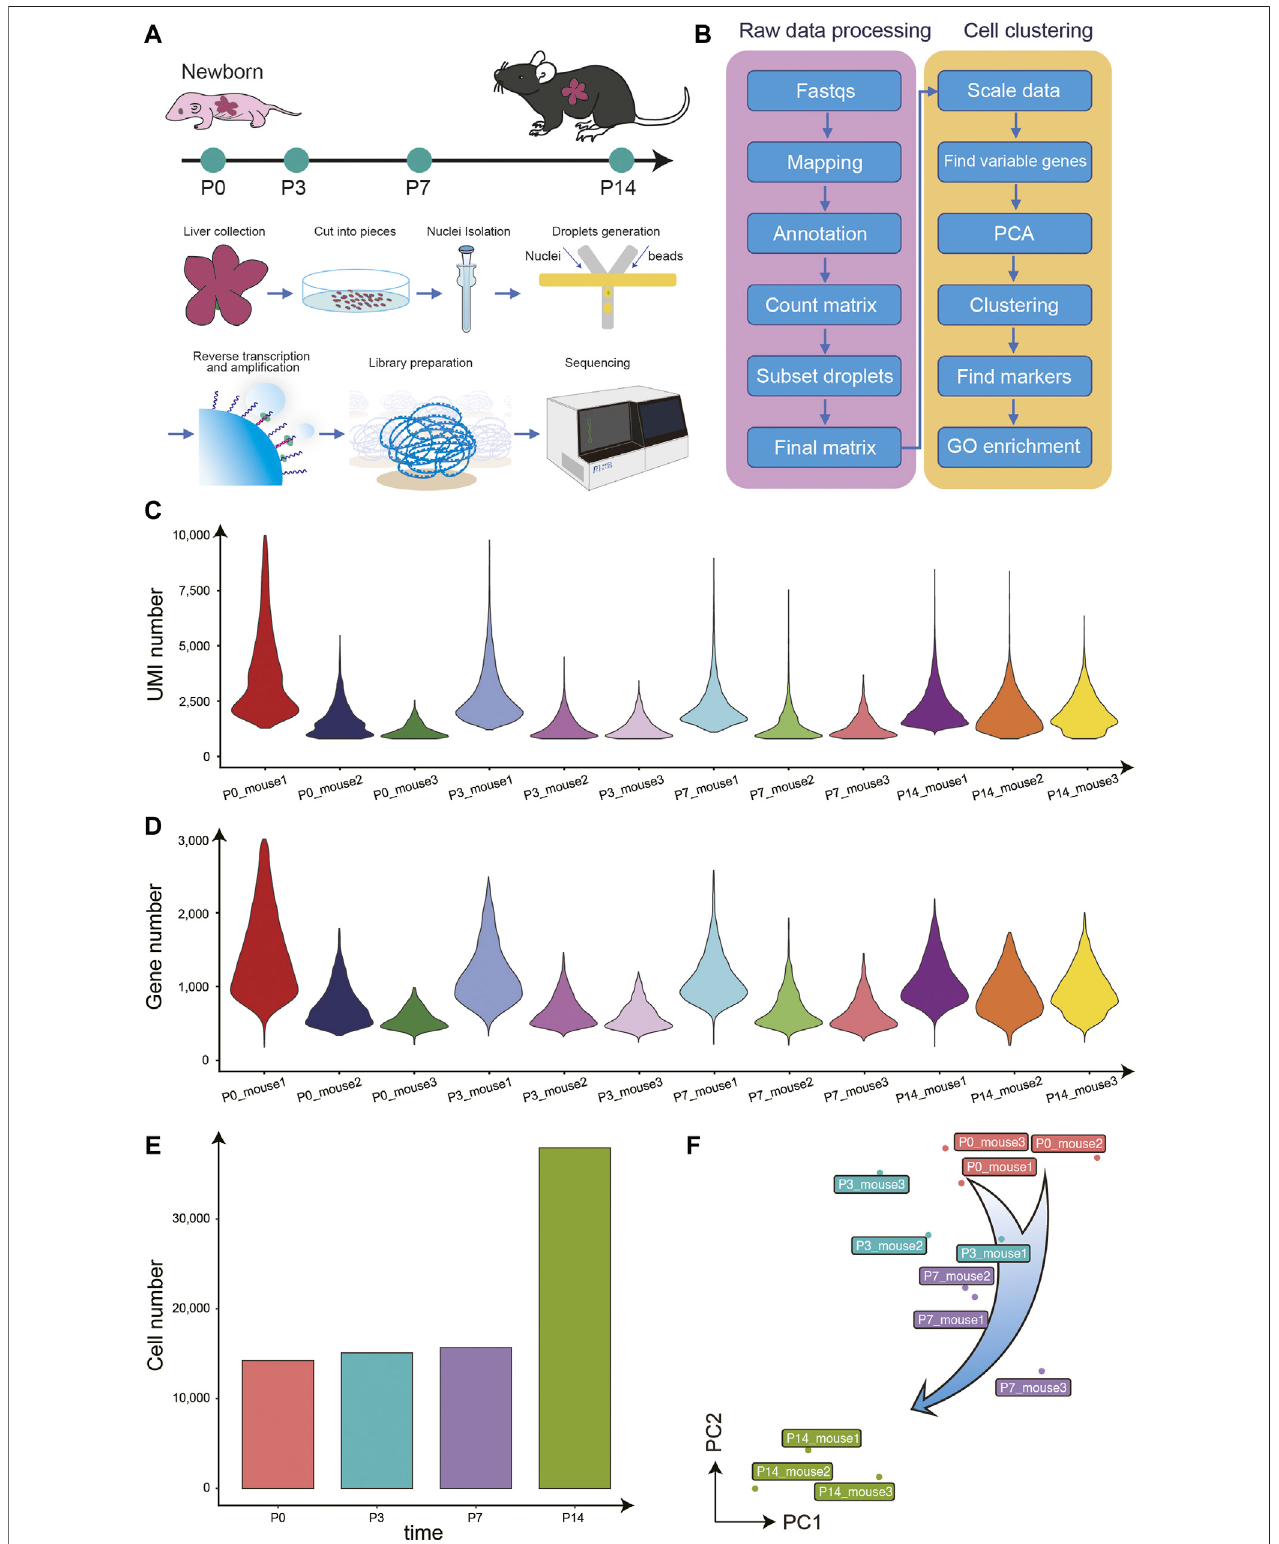
FIGURE 1 | Overview of the experimental design, data analysis work fl ow, and snRNA-seq data quality control. (A) The mouse liver samples of four different time pointsafterbirthwerecollectedforsnRNA-seqpro fi ling. (B) Theanalysiswork fl owforsnRNA-seqpro fi les. (C) TheviolinplotfortheUMIsnumberofeachlibrary. (D) The violin plot for the genes number of each library. (E) The histogram for the cell numbers each time point. (F) The PCA analysis for all libraries.